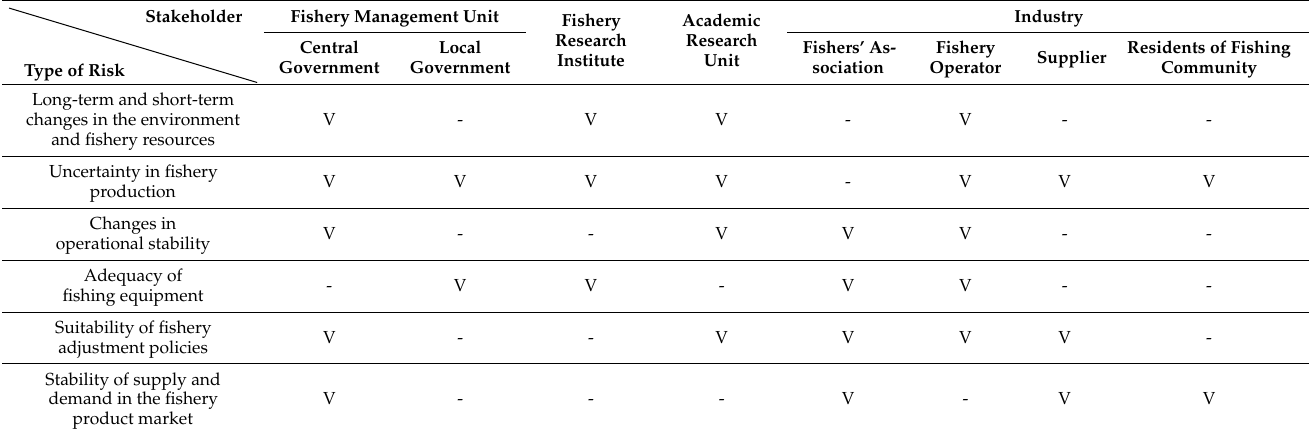
Table 1. Stakeholders in the marine fishery industry corresponding to climate risk types.